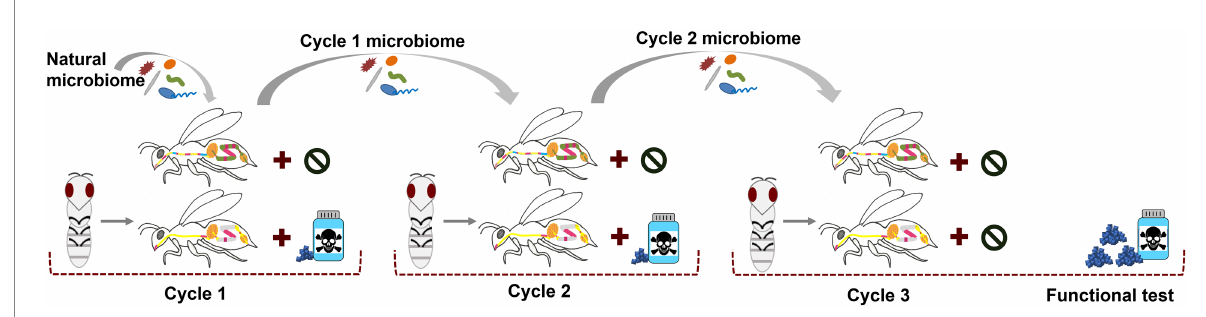
FIGURE 1 Design of the main experiment. Pupae emerge in the lab and are first inoculated for 48 h with a natural microbiome from hive siblings. Three cages per treatment were used. Throughout cycle 1 and 2, bees are continuously fed with sterile pollen and sucrose containing tetracycline or not (control). These exposed and control microbiome communities get passed to the following cycle of lab-emerged bees (cage to cage transfer). In cycle 3, bees that received control or pre-exposed microbiomes are kept naïve toward the chemical until they are administered high doses of tetracycline at the